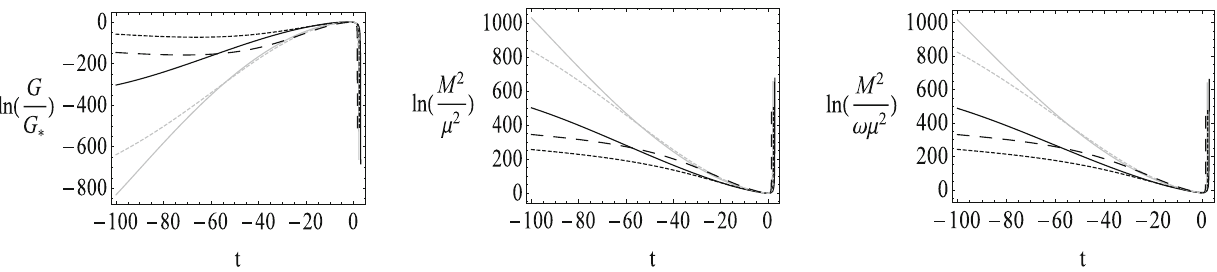
line), 0 . 3 (grey solid line), 0 . 35 (grey short-dashed line) and 0 . 45 (black long-dashed line). We took ρ ∗ = 1 . 5 and ξ ∗ = 10 5